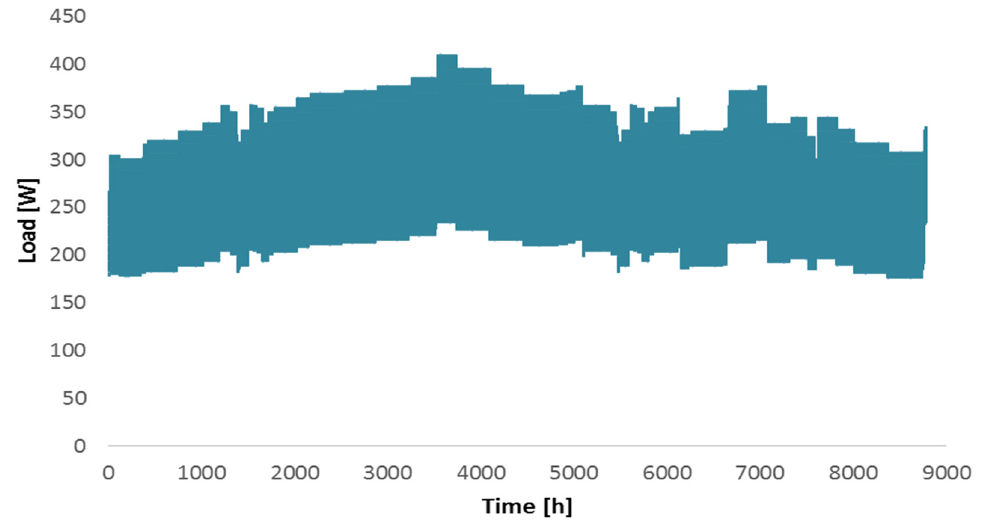
Figure 2. Load profile of the studied area.